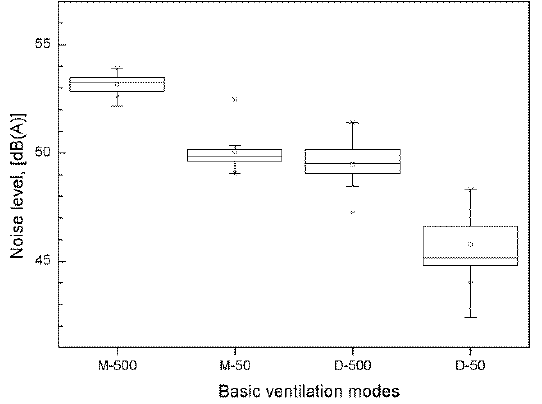
Figure 15. Noise levels in the test room (with background ventilation).